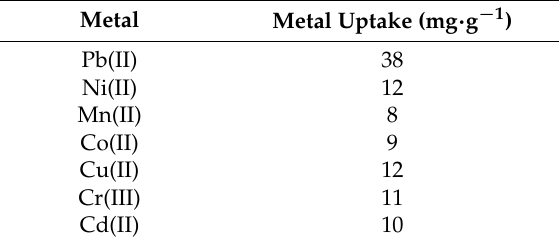
Table 10. Metals uptake in the active carbon.